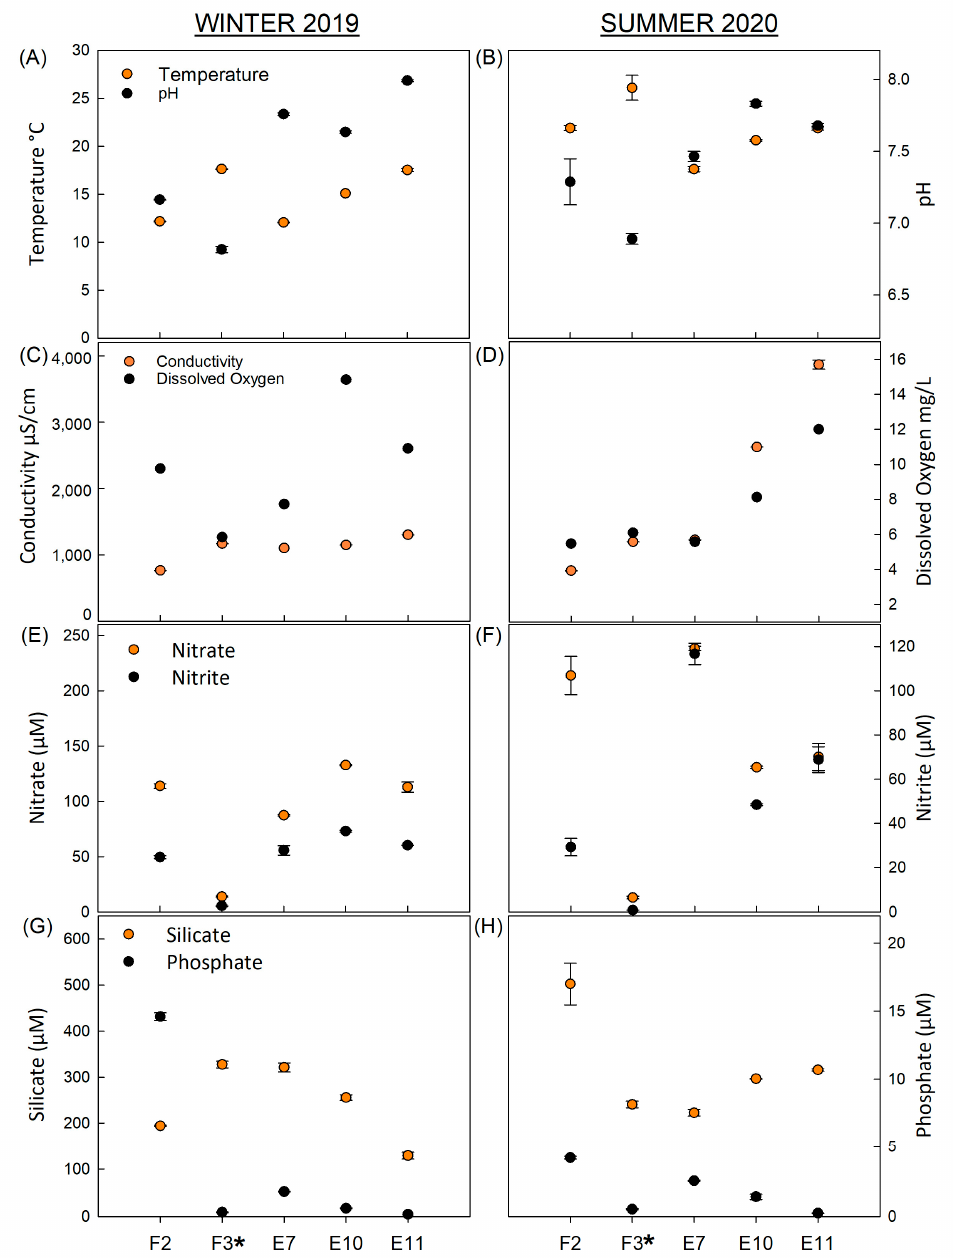
Figure 2. Physicochemical and nutrients conditions in all water samples during winter ( left panels ) and summer ( right panel ) of El Sauce estuary; Temperature ( A , B ); Conductivity ( C , D ); Nitrate and Nitrite ( E , F ), Silicate ( G,H ). * Discharge Station.